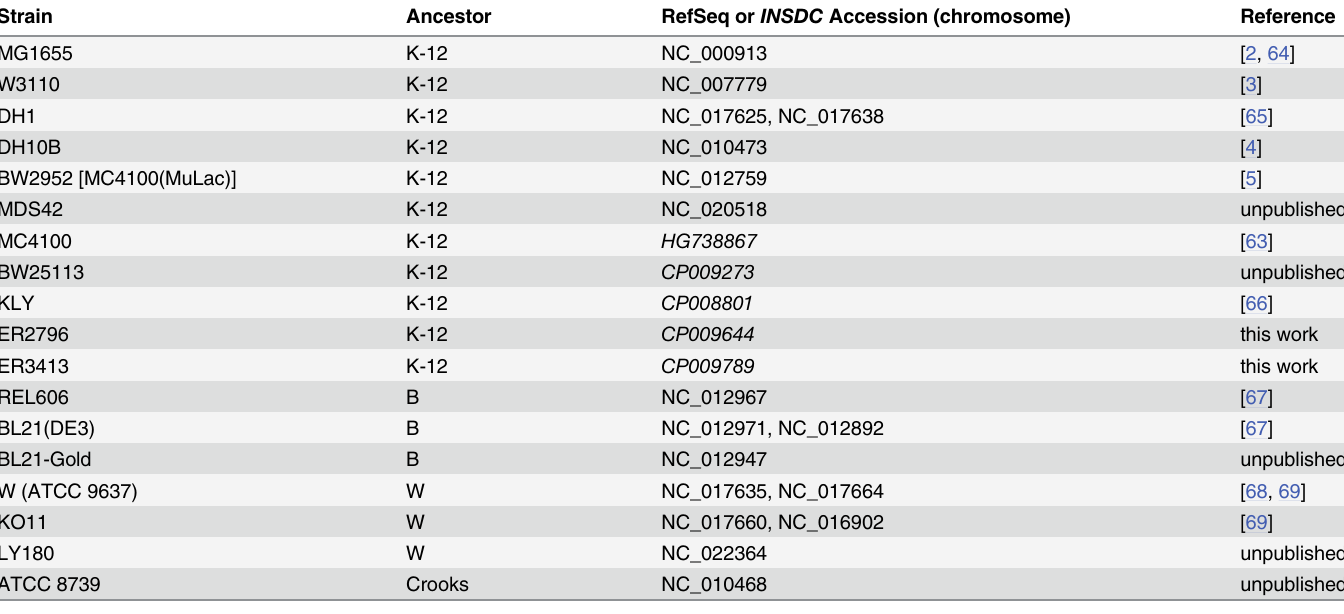
Table 1. Laboratory strains of E . coli with finished (ungapped) genome sequences in GenBank. Strain